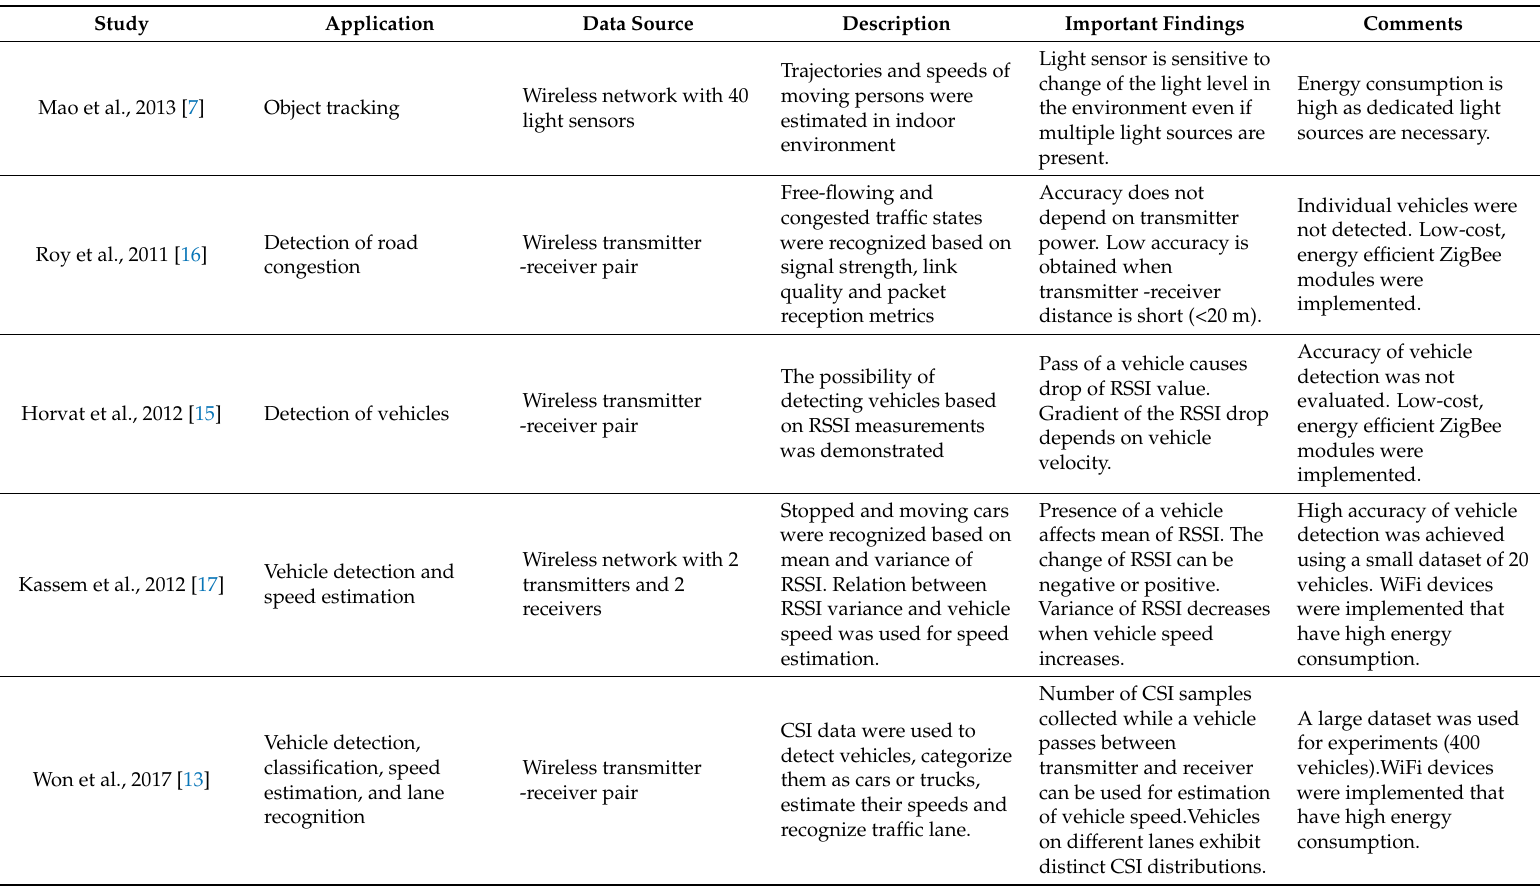
Table 2. Representative works related to low-cost traffic monitoring